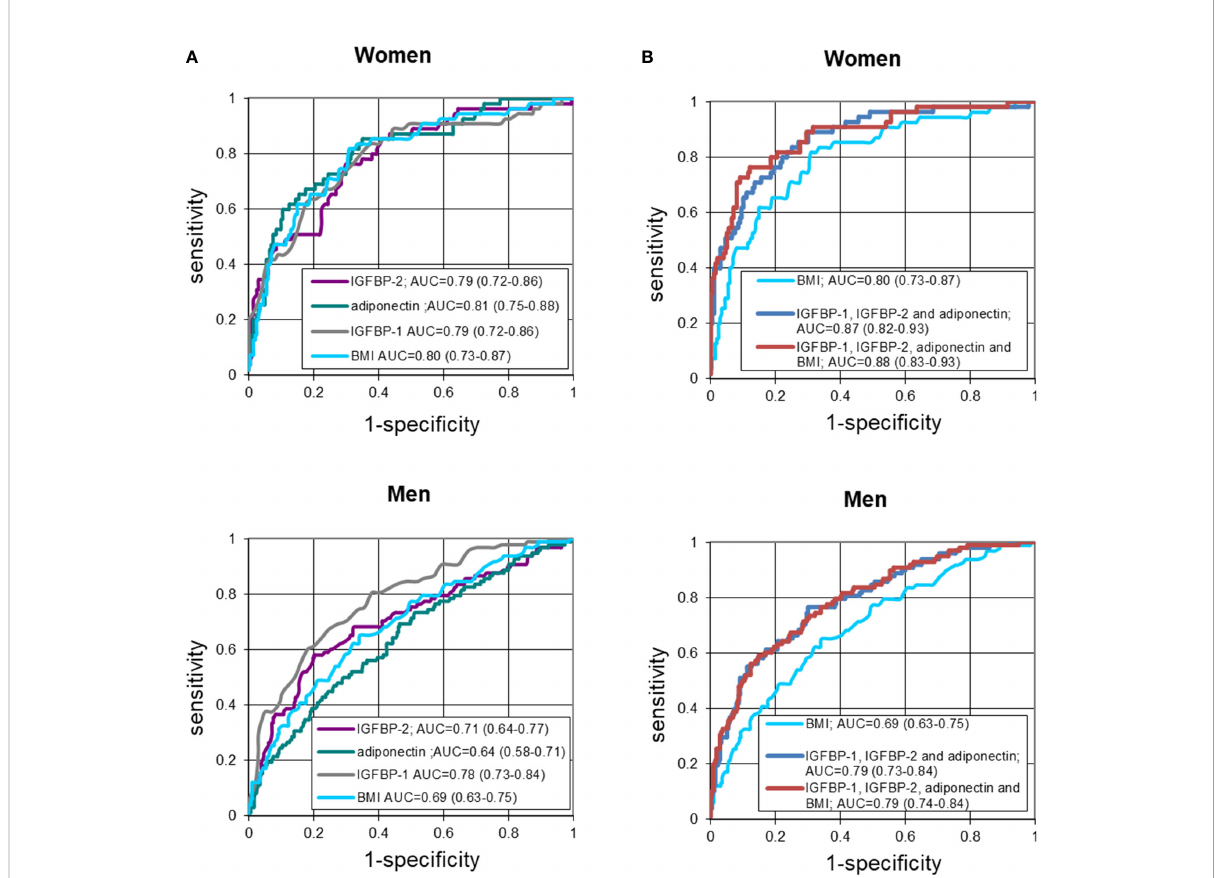
FIGURE 1 (A) Receiver-operating characteristic (ROC) curves offasting IGFBP-2, adiponectin, IGFBP-1 and BMI in detecting T2D in women and men. Logistic regression models not adjusted for confounders. (B) Receiver-operating characteristic (ROC) curves offasting IGFBP-2, adiponectin and IGFBP-1 combined, as compared to BMI alone or included, in detecting T2D in women and men. Logistic regression models not adjusted for